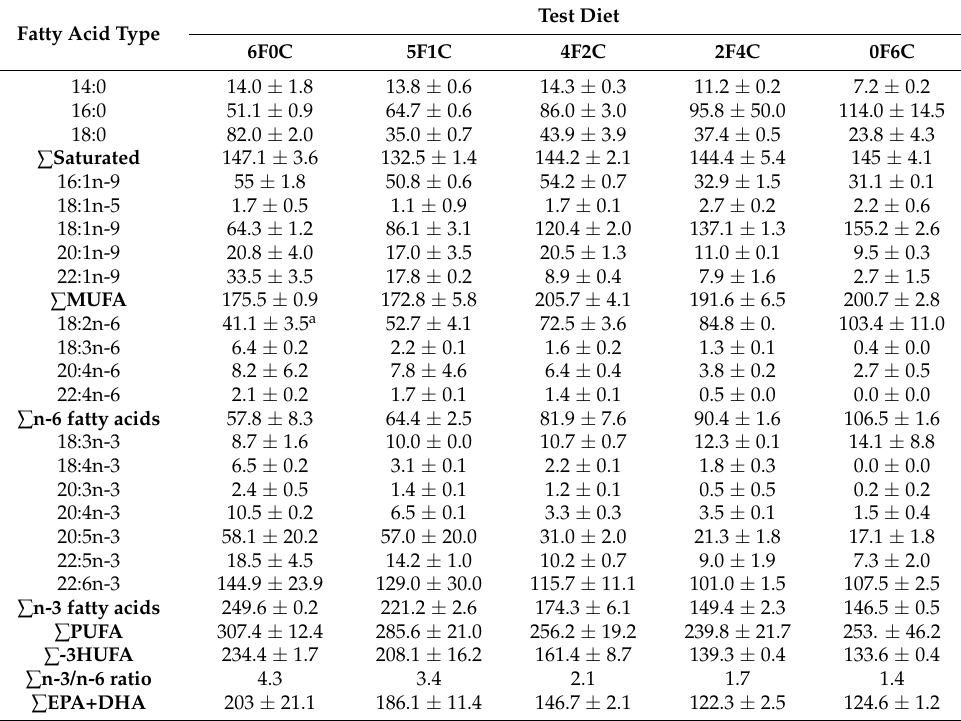
Table 2. Fatty acid composition (mg/g lipids) in experimental diets. Fatty Acid